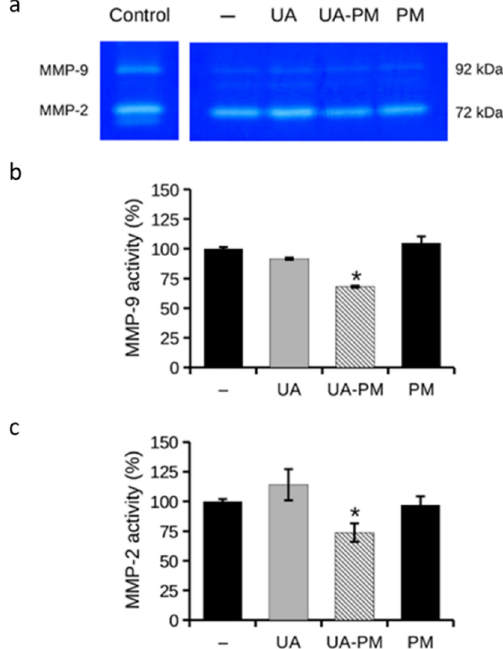
Figure 8. Effect of UA and UA–PM on MMP-2/9 release in culture medium. ( a ) Representative image of gelatin zymography of cell culture media collected at 24 h from SH-SY5Y cells untreated ( − ) or treated with UA (0.2 µg/mL), UA–PM (0.2 µg/mL), and PM (1:2500). Culture medium of untreated HT1080 human fibrosarcoma cells was used as a control for the molecular size of MMPs (Control). Quantitative data of gelatinolytic bands of (b) MMP-9 and (c) MMP-2. Data are reported as means ± SD from three different experiments. * p < 0.05 vs. untreated control cells. Tukey’s test ( n = 3)